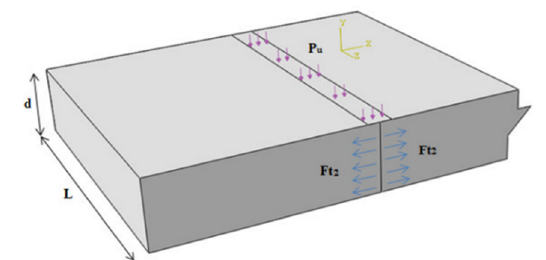
Fig. 10. The Splitting Tensile Stress.